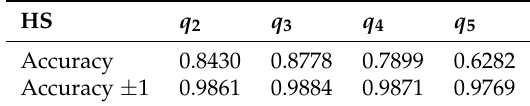
Table 1. Accuracy for prediction with heuristic solution